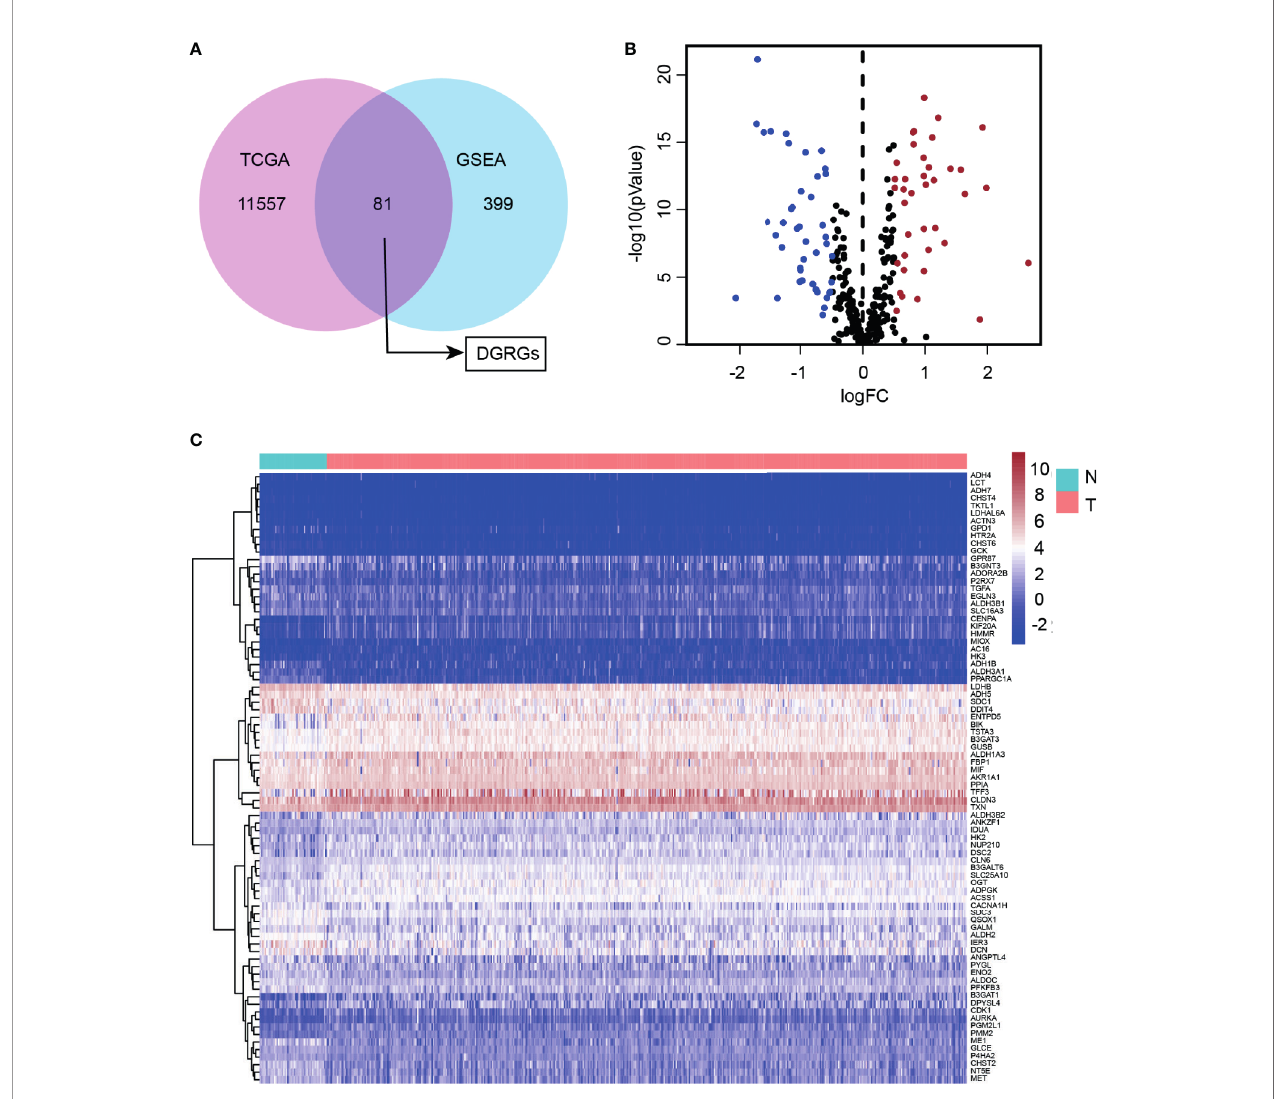
FIGURE 1 | Identi fi cation of differentially expressed glycolysis-related genes in prostate cancer cohort. (A) Venn diagram showed overlapping of TCGA and GEO70770 database. (B) Volcano plot of differentially expressed glycolysis-associated genes expressed mRNA. (C) Heatmap of the differentially expressed glycolysis-associated genes showing expression signature in patients with